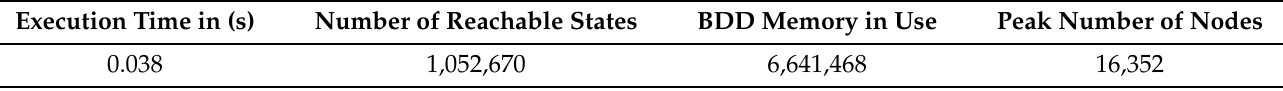
Table 2. Properties of the verification of the agent logic during design-time in MCMAS model checker. Execution Time in